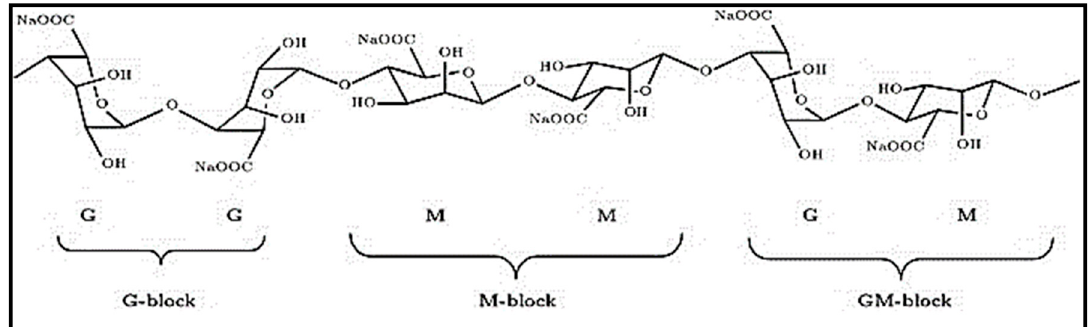
Figure 5. Types of alginate blocs: M = mannuronic acid; G = guluronic acid [75].